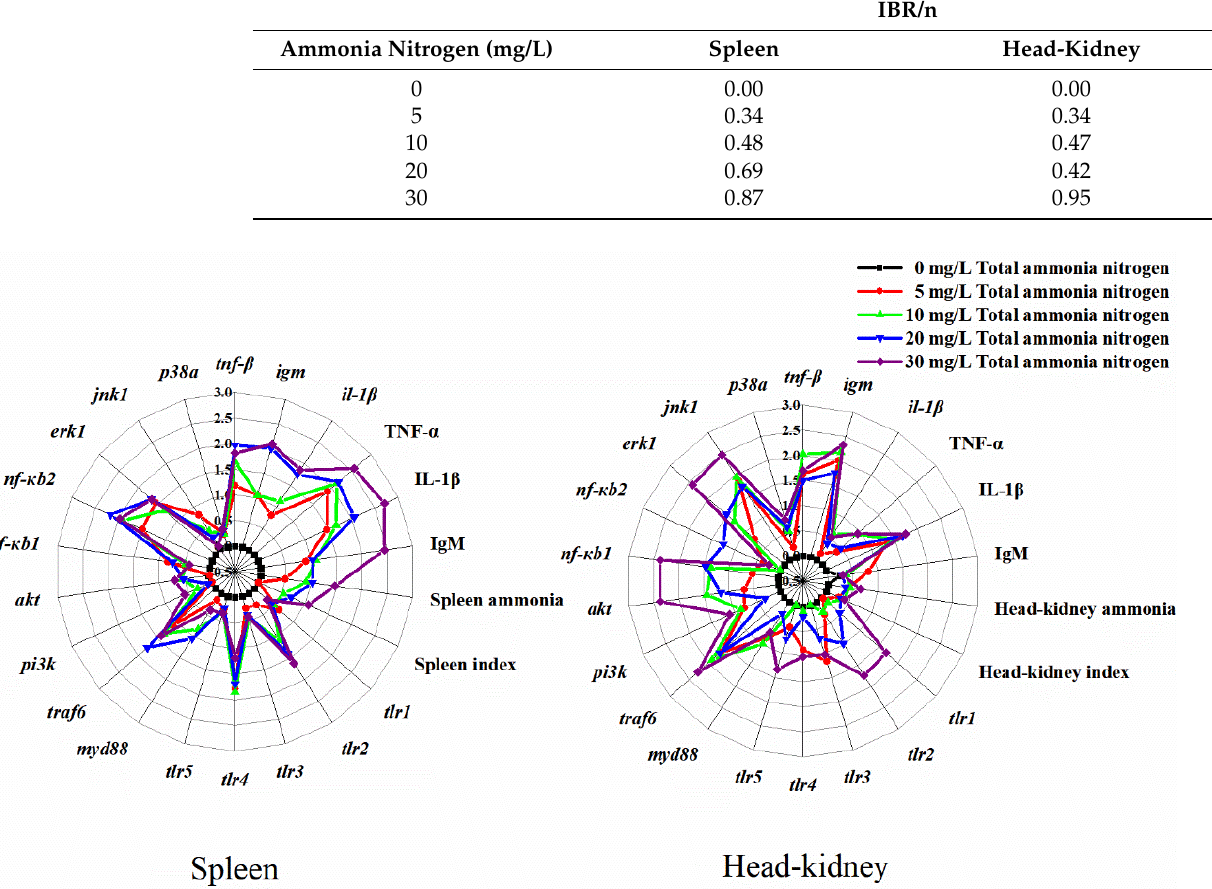
Figure 8. Star plots for biomarker responses in spleen and head-kidney in M. amblycephala exposed to ammonia nitrogen.